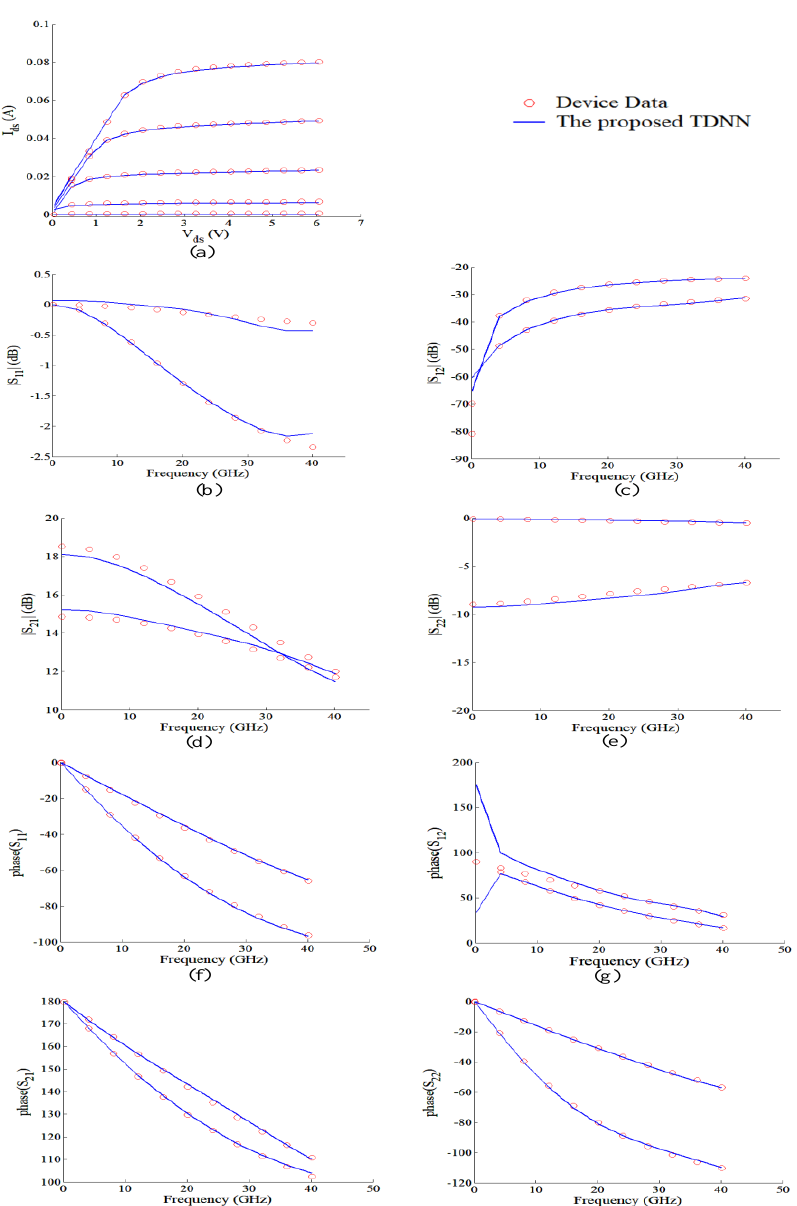
Figure 6. Comparison between the proposed TDNN model and the device data using DC and S-parameters at multiple biases for the HEMT example. ( a ) DC. ( b – i ) Magnitudes and Phases of S-parameters at two test biases of ( V g and V d ) at (0.1 V, 5.6 V) and (0.7 V, 2.1 V). The DC and S-parameters shown in the figure from proposed TDNN is test data which is never used in the training.